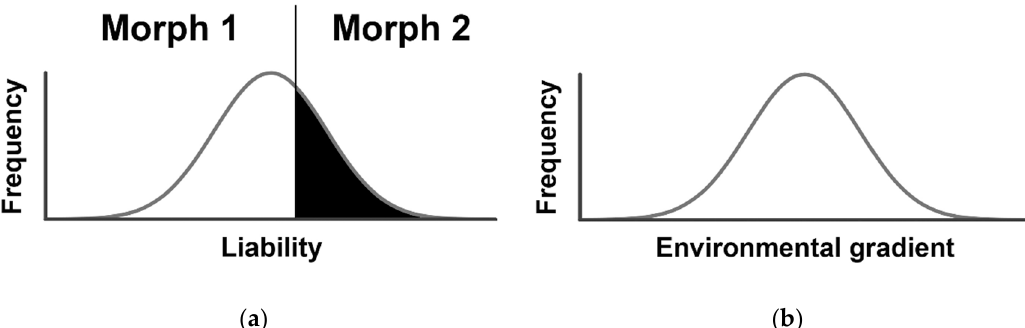
Figure 1. Threshold genetic models for dimorphic traits, such as migratory vs. non-migratory morphs. ( a ) The classical threshold genetic model. Liability represents the normally-distributed underlying trait (gray curve), with the vertical line indicating a fixed threshold that determines the transition from one morph to another; ( b ) The environmental threshold model. Here, the genetically-determined thresholds for transition between morphs are normally distributed (gray curve), and correspond to the level of an environmental variable. After Roff [28].